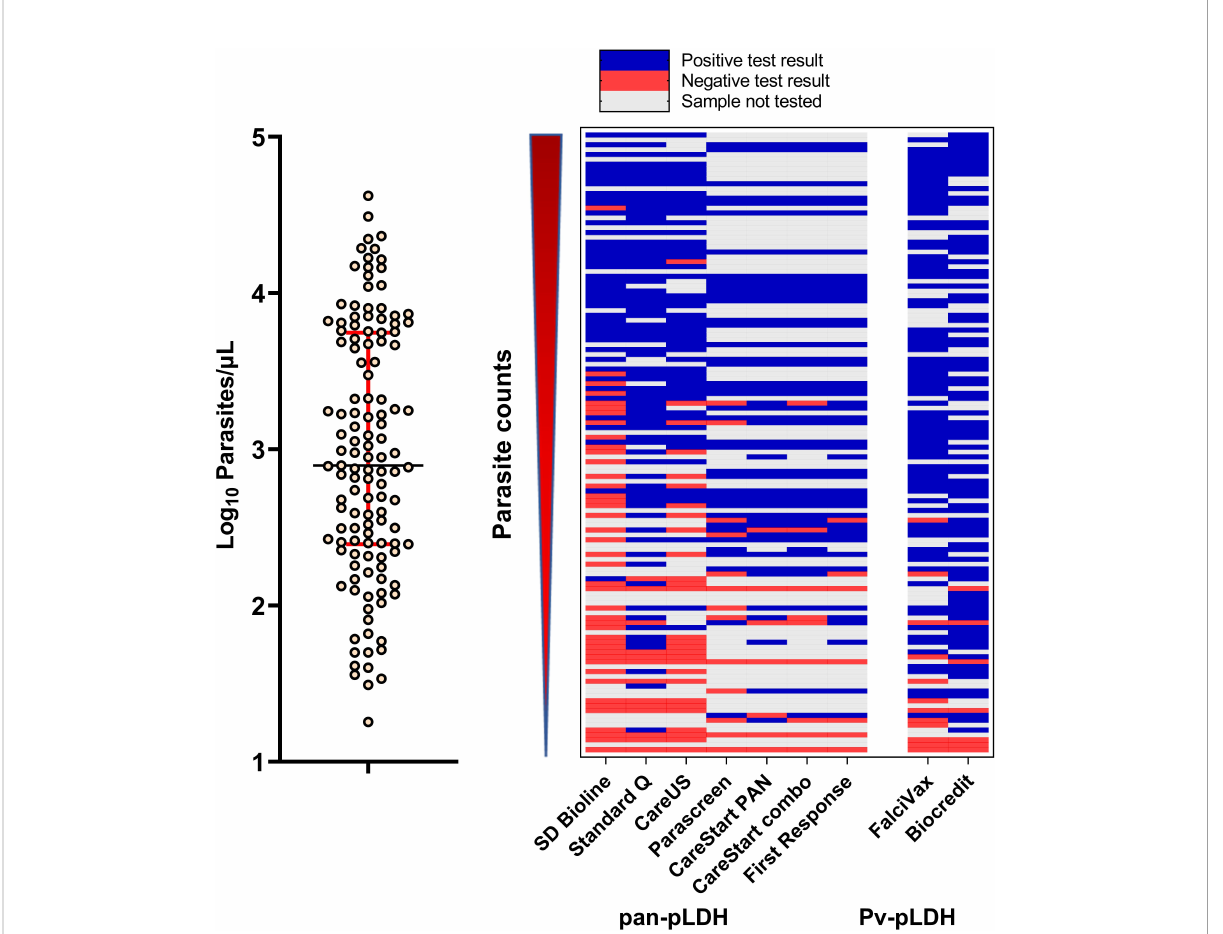
FIGURE 3 (Left) Distribution of parasite counts of clinical samples tested. (Right) Overview of tested samples with increasing parasite counts and corresponding outcomes in the nine RDTs tested for detection of clinical P. knowlesi